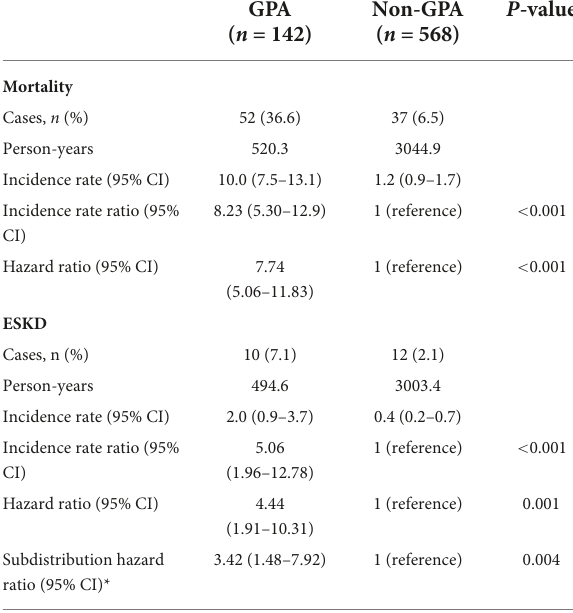
TABLE 3 Incidence rate (per 100 person-years) and hazard ratio of mortality and end-stage kidney disease (ESKD) in patients with granulomatosis with polyangiitis (GPA) compared with the non-GPA population. P GPA Non-GPA ( n = 142) ( n = 568)